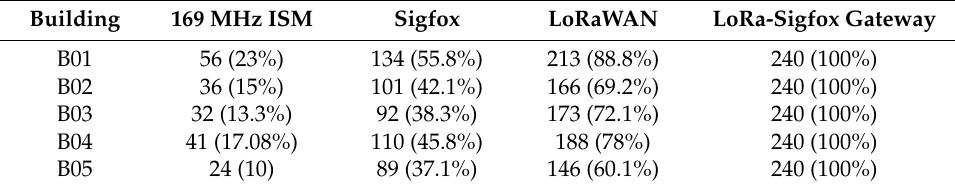
Table 1. Reception rates over a period of 10 days (240 samples) with each of the different systems tested in a water-meter with a percentage of received samples ranged lower than 25% over expected in the 169 MHz ISM